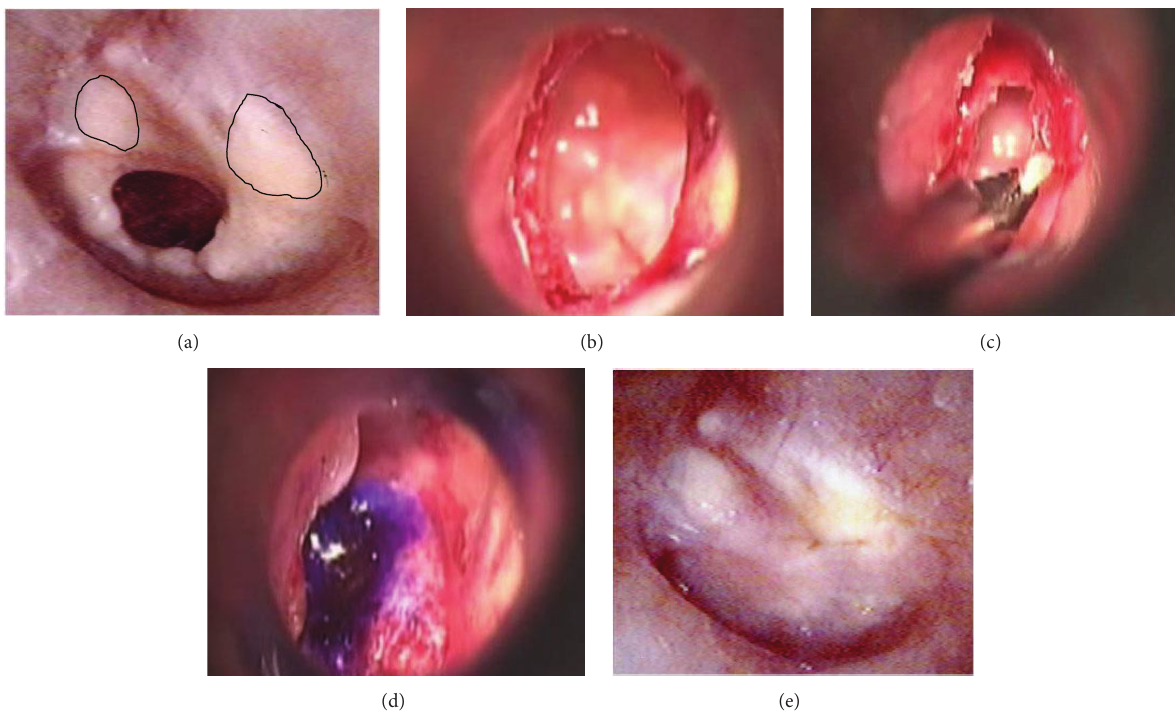
Figure 1: Operative procedures of simple underlay myringoplasty in a representative case with myringosclerosis. (a) The preoperative perforated tympanic membrane with myringosclerosis (the area surrounded by solid lines). (b) The refreshened edge of the perforation. (c) Removal of myringosclerotic deposits. (d) The underlay graft with marked purple. (e) The postoperative finding of the tympanic